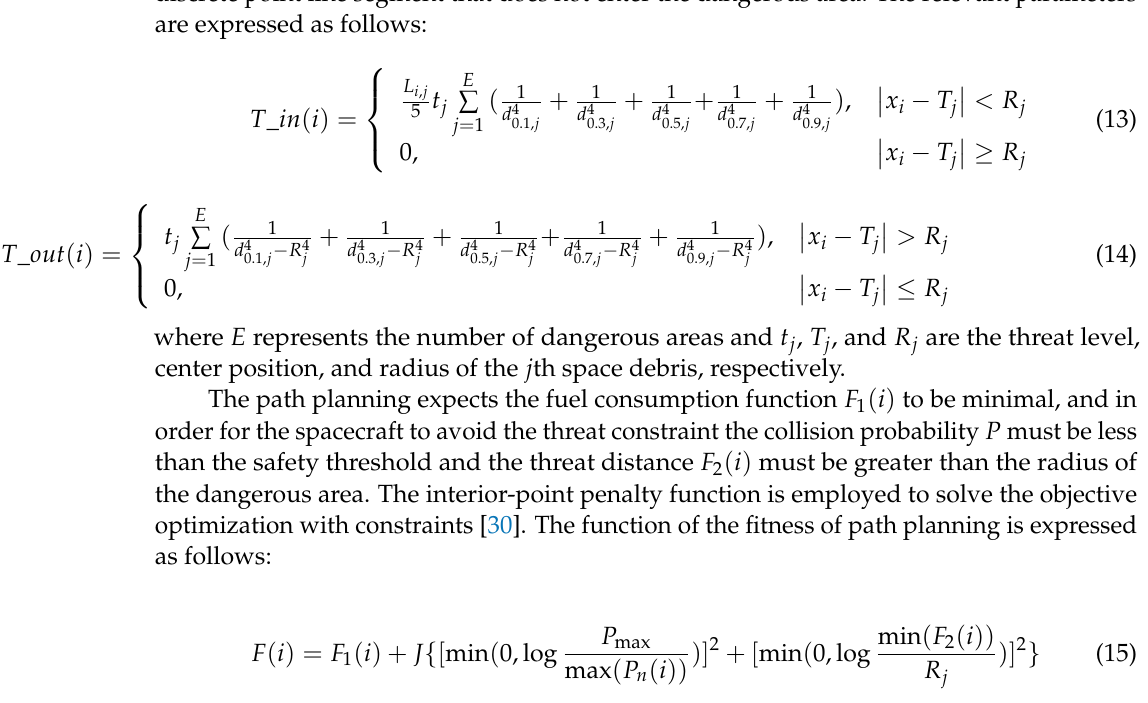
where m 1 + m 2 + m 3 = 1, L i , k is the length of the j th planning segment of the i th discrete point, T − in represents the dangerous distance from the i th discrete point to the ( i + 1)th discrete point line segment entering the dangerous area, and T − out is the dangerous distance from the i th discrete point line segment that does not enter the dangerous area to the ( i + 1)th discrete point line segment that does not enter the dangerous area. The relevant parameters